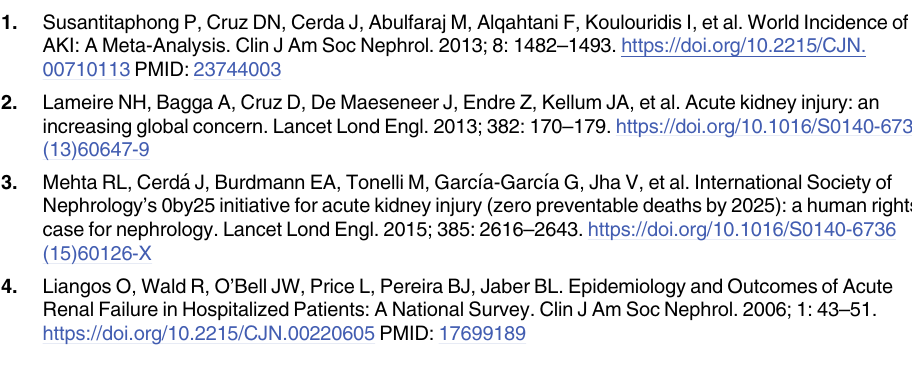
S1 Table. Characteristics of population according to ICU admission during hospital stays in metropolitan France between 2009 and 2014. S2 Table. Univariate and multivariable analyses of admission to intensive care units of AKI patients requiring